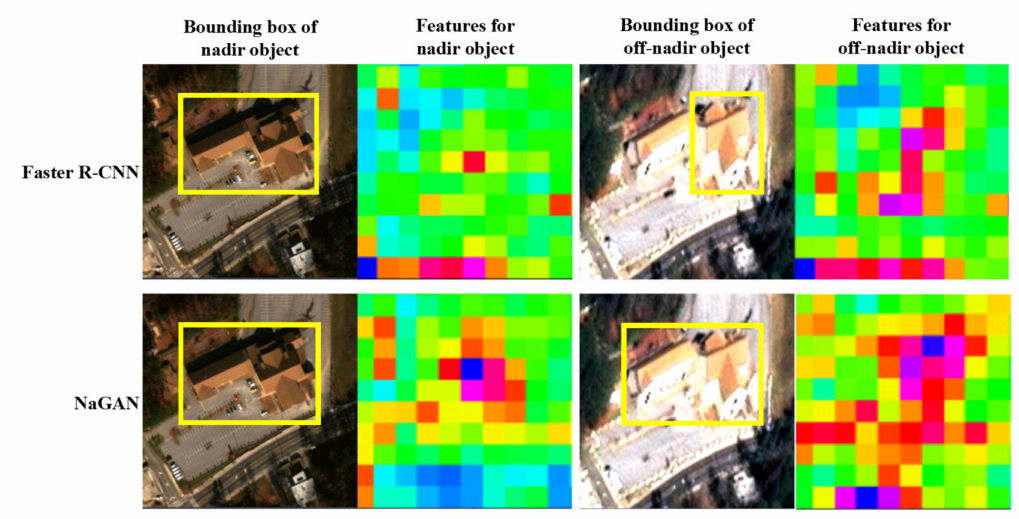
Figure 6. Bounding boxes and feature maps of Faster R-CNN and NaGAN in nadir and off- nadir